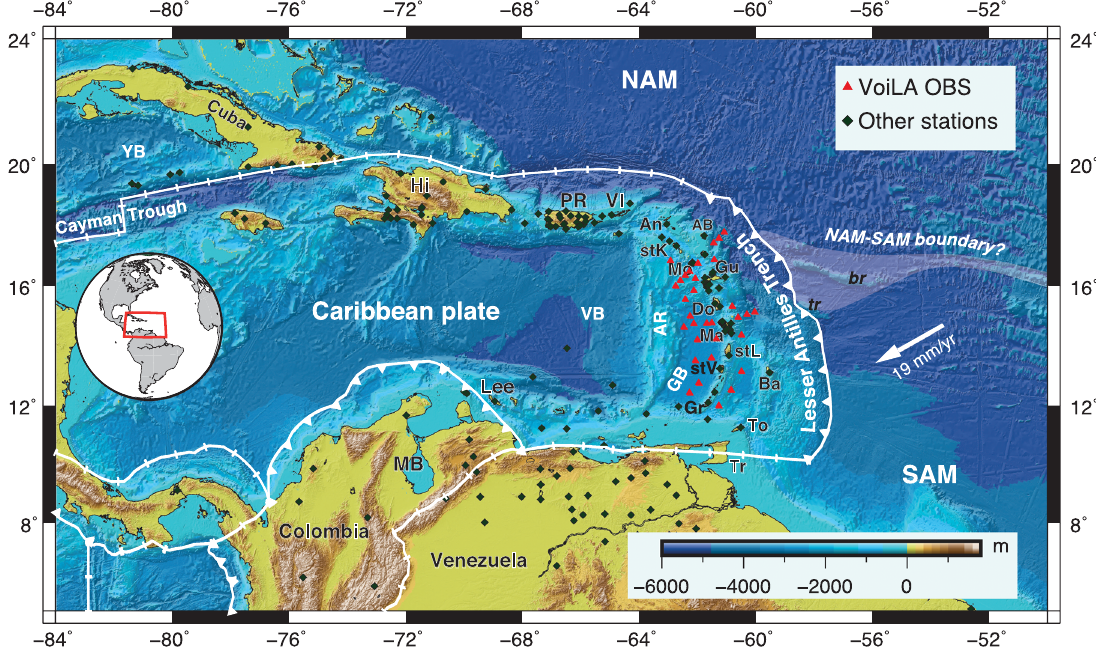
Fig. 1 Current tectonic map of the Caribbean. Plate boundaries from Bird 66 . Uncertainty in the position of the NAM – SAM plate boundary is indicated by white shading. Plate motion vector is for Atlantic sea fl oor relative to the Caribbean plate 26 . Regional seismic networks used for this study include our VoiLA experiment with ocean-bottom seismometers (red triangles) and additional land stations (dark-green diamonds) from which data were added to the global EHB catalogue 53 . An Anguila, AB Antigua and Barbuda (Limestone Caribbees), AR Aves Ridge, Ba Barbados, br Barracuda Ridge, Do Dominica,